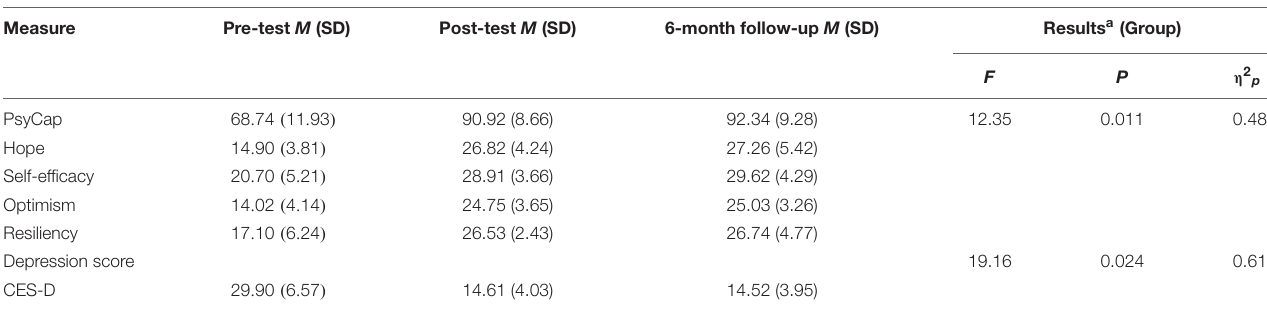
TABLE 3 | Descriptive summaries of the treatment outcome measures for the PCI